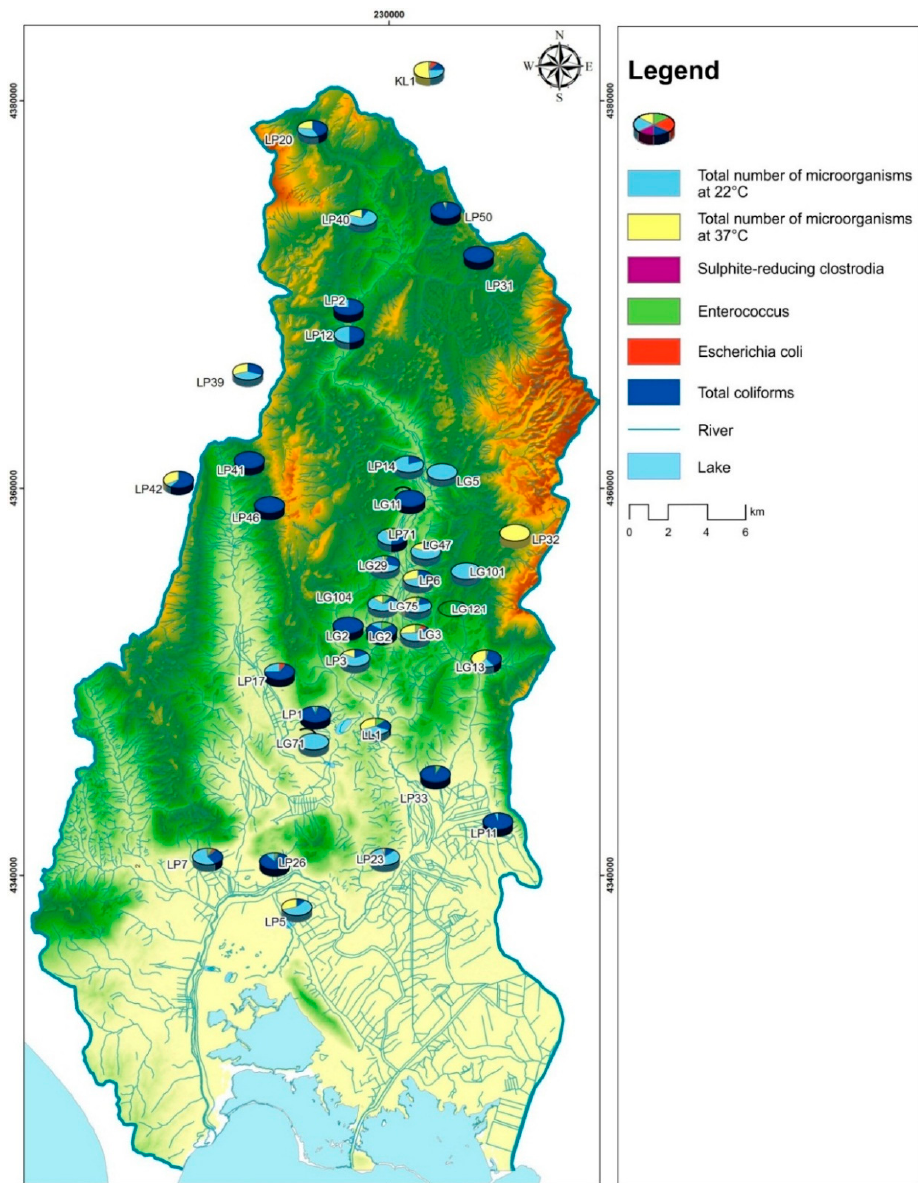
Figure 4. The pie charts of THE microbial load along Louros Basin.